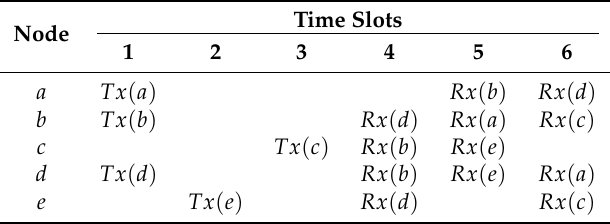
Table 2. Node/time slot allocation for transmission of